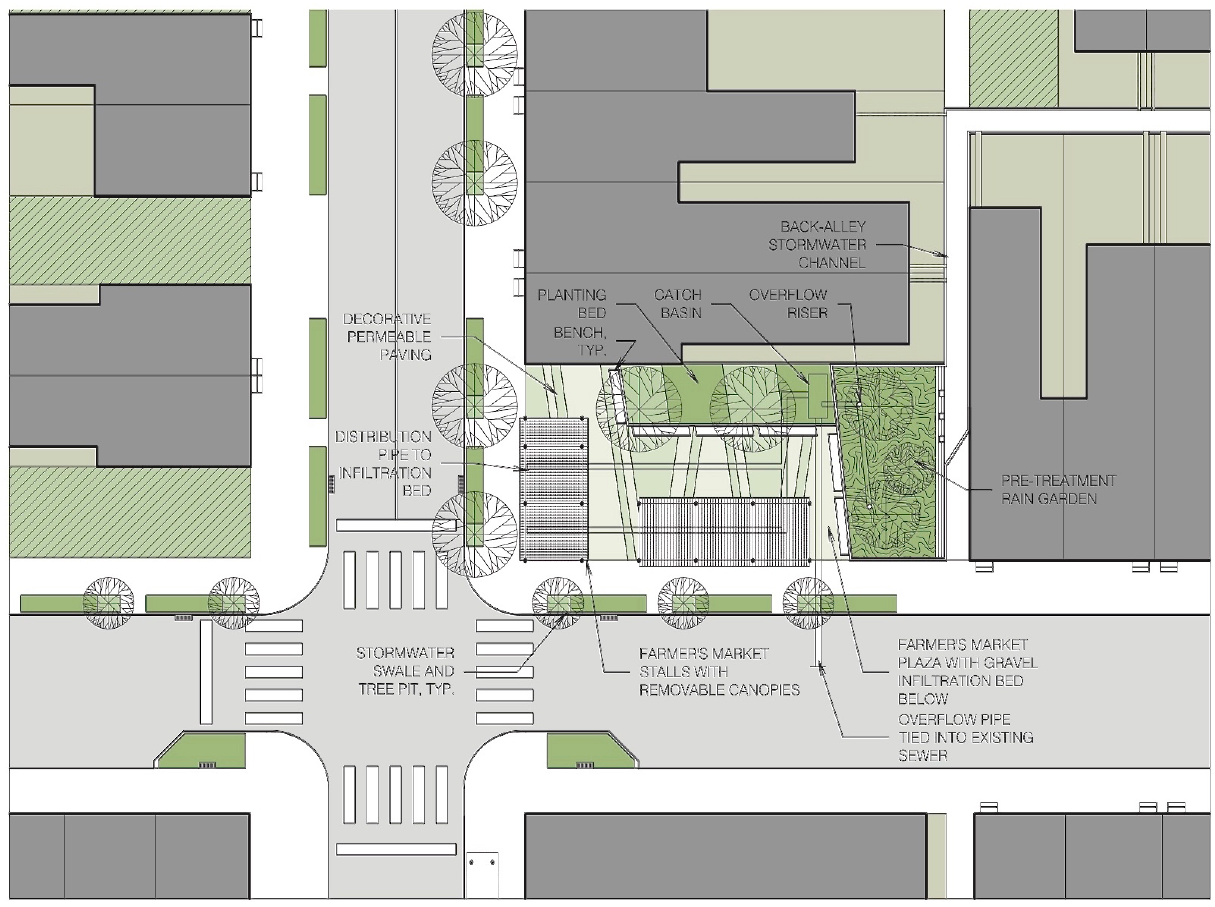
Figure 8. Model 3—Conceptual design for corner